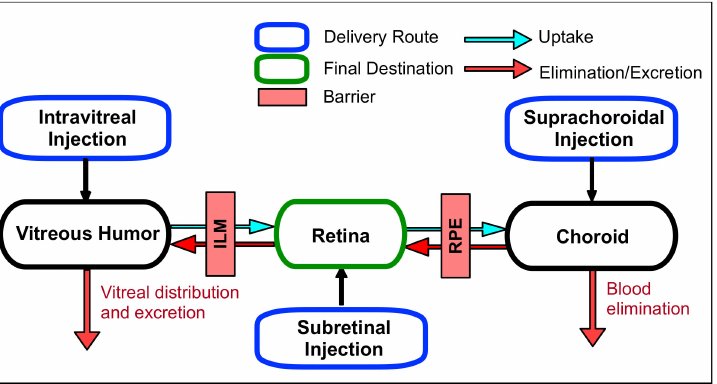
Figure 3. Intraocular injection delivering drugs in close proximity to the retina. After intravitreal or suprachoroidal injection, the only major barrier present is the internal limiting membrane (ILM) and retinal pigment epithelium (RPE), respectively. Subretinal injection directly delivers the drug to the